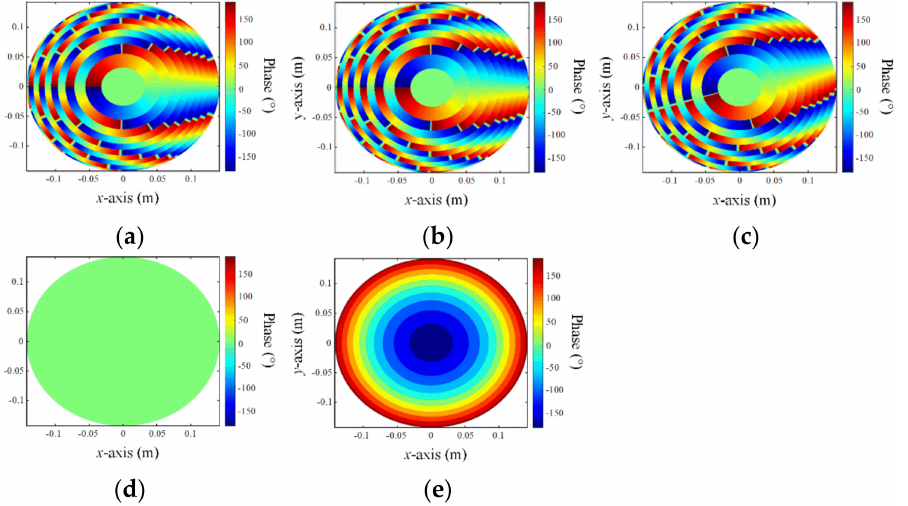
Figure 2. Transmitting phase distributions of Moir é lens: ( a ) T 1 ; ( b ) T 2 ( θ r = 0 ◦ ); ( c ) T 2 ( θ r = 30 ◦ ); ( d ) T 12 ( θ r = 0 ◦ ); and ( e ) T 12 ( θ r = 30 ◦